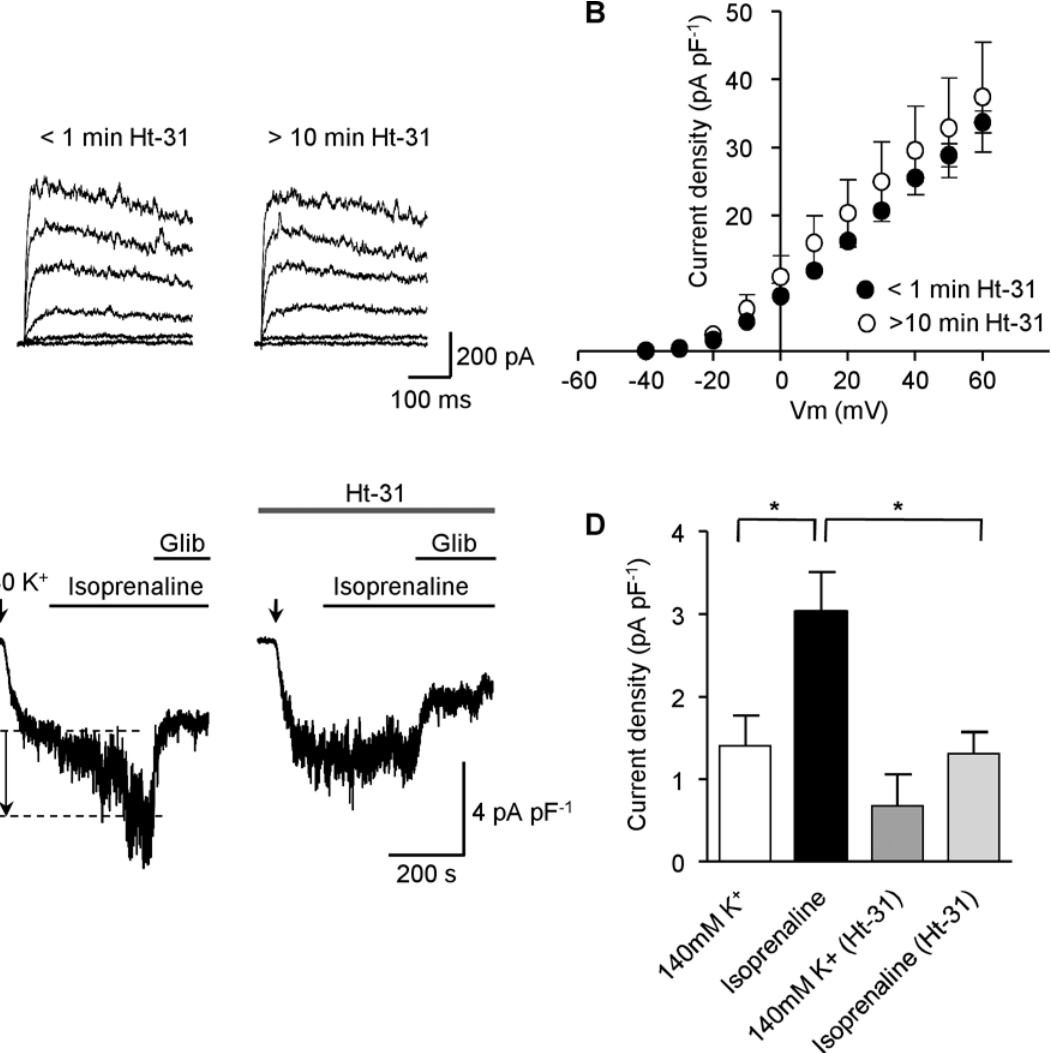
Fig 6. PKA activation of K v currents remained following disruption of PKA-AKAP interactions. ( A ) Representative K v current traces obtained immediately after establishing whole-cell recording ( < 1 min Ht-31) and 10 min following establishment of the whole-cell configuration with 20 μ M Ht-31 in the patch pipette. ( B ) Mean ( ± s.e.m.) I-V plots (current density normalized to cell capacitance) immediately after establishing whole-cell recording and 10 min after establishing whole cell configuration in the presence of Ht-31 (20 μ M) in the patch pipette (n = 5). ( C ) Representative K ATP current traces (normalized to cell capacitance) following the application of 100 nM isoprenaline in the absence or presence of 20 μ M Ht-31 in the patch pipette; the current increase in response to isoprenaline is indicated by the dashed lines and arrow. ( D ) Mean glibeclamide-sensitive current (normalized to cell capacitance)